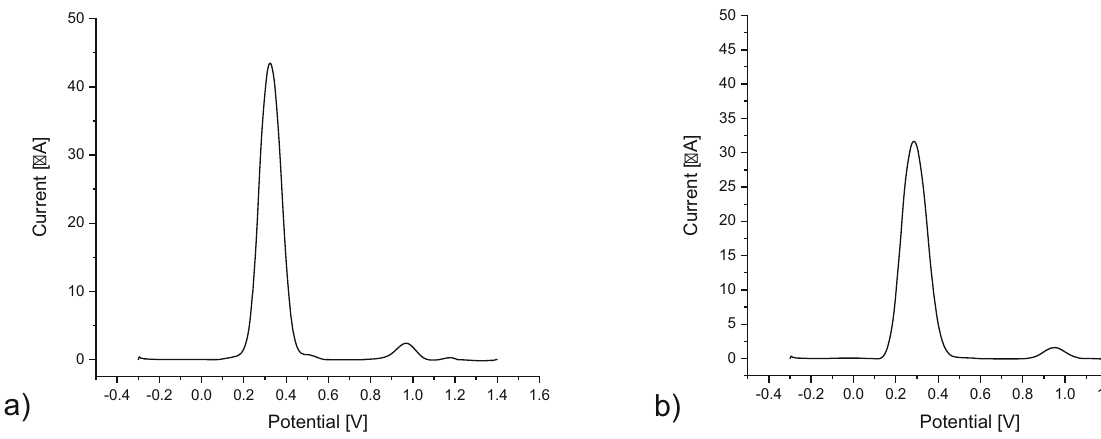
-0.4 -0.2 0.0 0.2 0.4 0.6 0.8 1.0 1.2 1.4